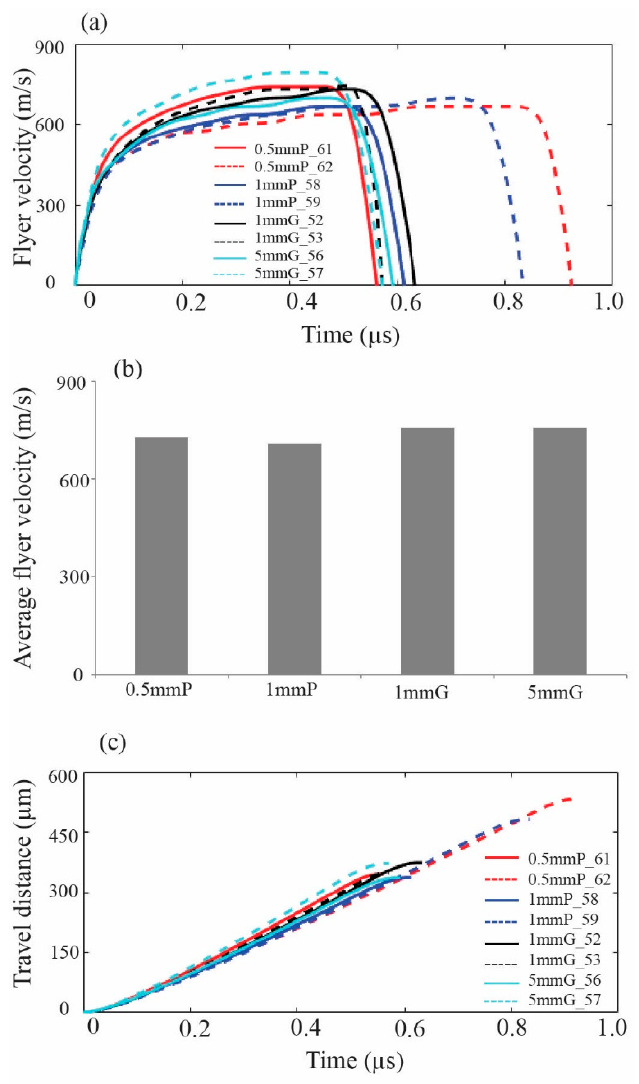
Figure 8. ( a ) Flyer velocity as a function of time, ( b ) average flyer velocity with various confinement layers, ( c ) flyer travel distance as a function of time ( E = 3.1 J, D = 4 mm, t = 25 µ m, 0.5mmP_61: 0.5 mm thick polycarbonate as the confinement layer for experiment number 61, 1mmG_52: 1 mm thick glass as the confinement layer for experiment number 52).